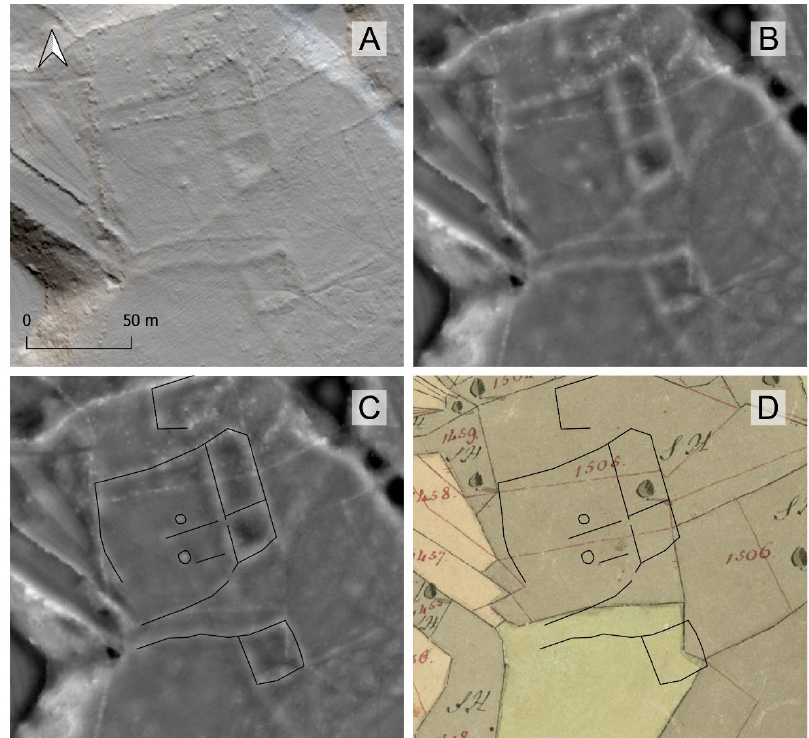
Figure 15. Zoomed view of the rural complex of area H: hill-shaded image ( A ), local relief model ( B ), interpreted local relief model ( C ) and digitized features superimposed onto a 19th century cadastral map ( D ).